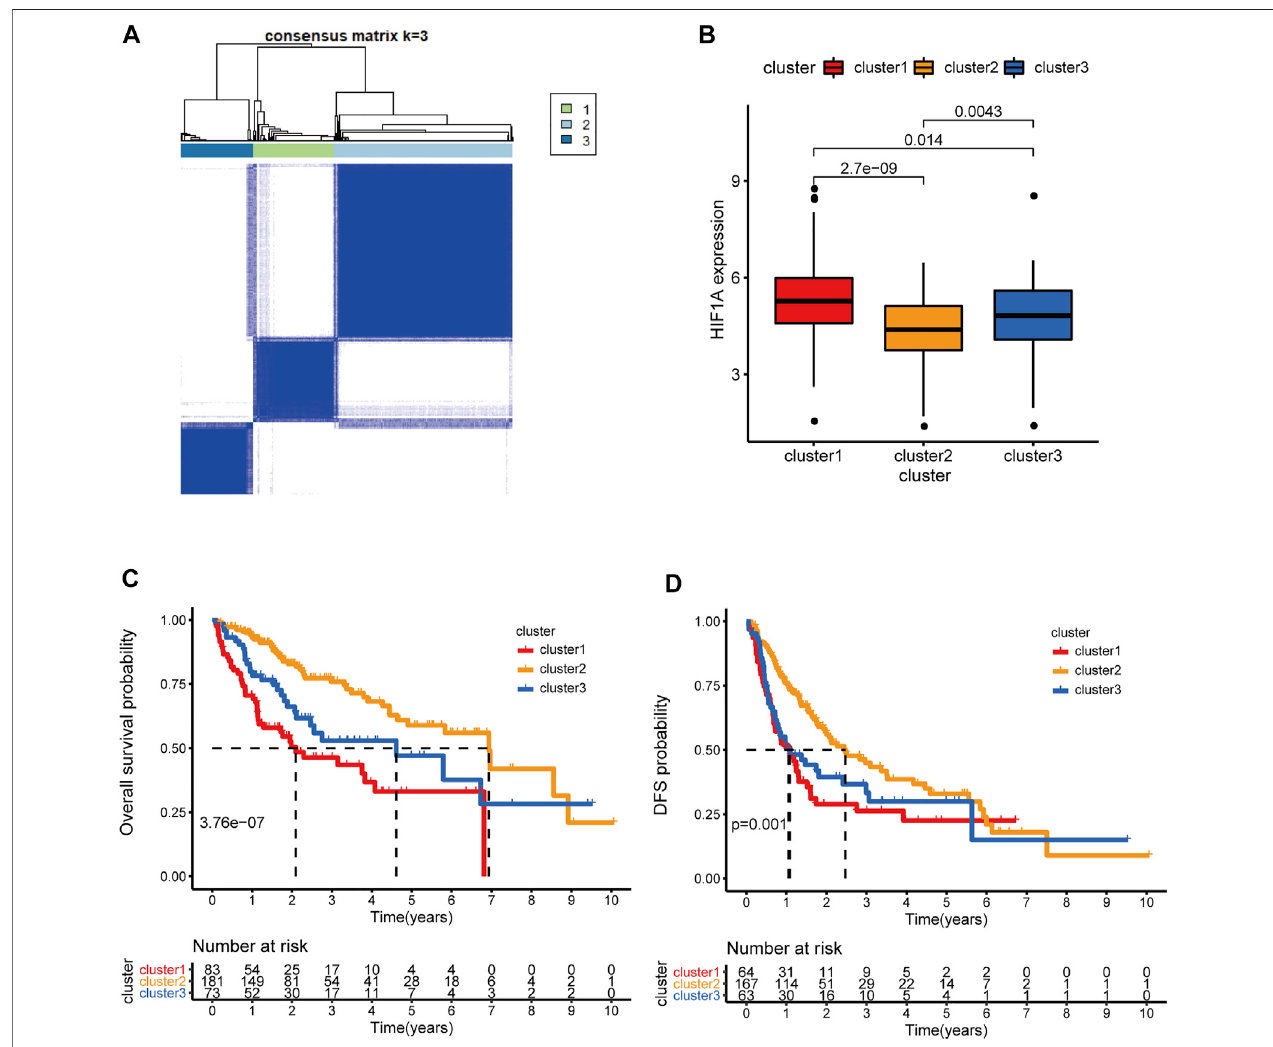
FIGURE 2 | Microdissection of the hypoxia-related lncRNA landscape in TCGA-LIHC cohort. (A) the Consensus matrix plot of HCC patients by unsupervised clustering (K-means method) according to the expression levels of 55 HRDELs, when k (cid:1) 3 representing the optimal cluster number. (B) Comparison of HIF1A mRNA expression among theHRDEL-speci fi cclusters. (C) Overallsurvivaldifference and (D) DFS difference among hypoxia-speci fi cclusters. HCC: hepatocellular carcinoma. HRDELs: hypoxia-related differentially expressed lncRNAs. DFS: disease-free survival.